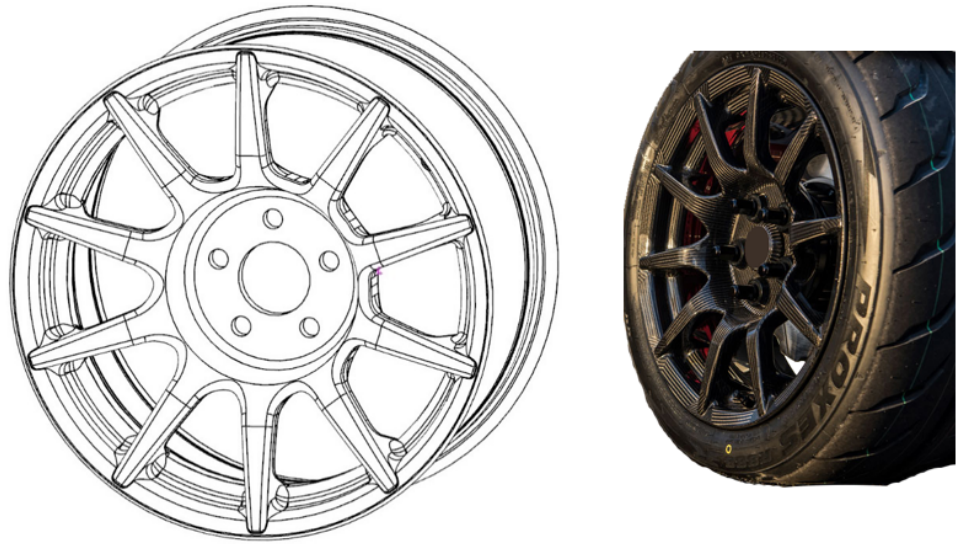
Figure 2: (a) Computer model of the tested wheel; (b) Manufactured BST wheel fitted to a tyre